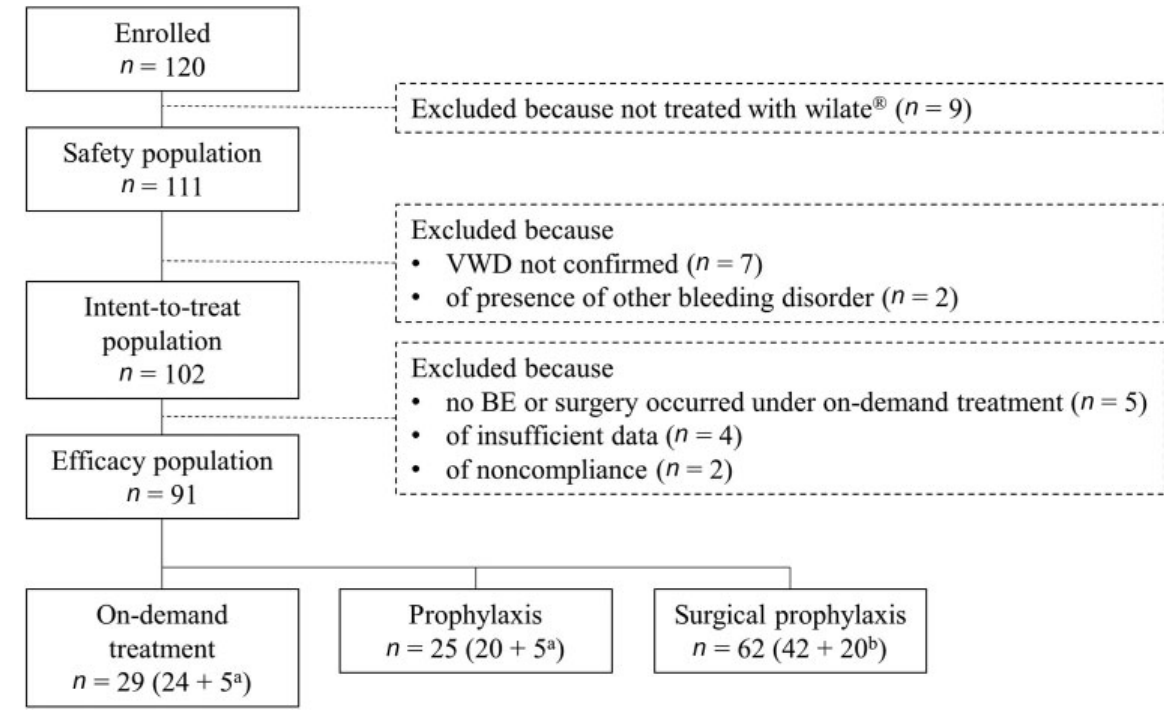
Fig. 1 Patient disposition. a Two patients changed from on-demand treatment to prophylaxis, and three patients changed from prophylaxis to on-demand treatment. For all analyses by treatment regimen, these fi ve patients were included in both analysis populations. Seven patients treated on-demand and two treated prophylactically also received treatment for menstrual bleeding. b Forty-two patients underwent surgery only, and 20 patients were also included in the on-demand or prophylaxis